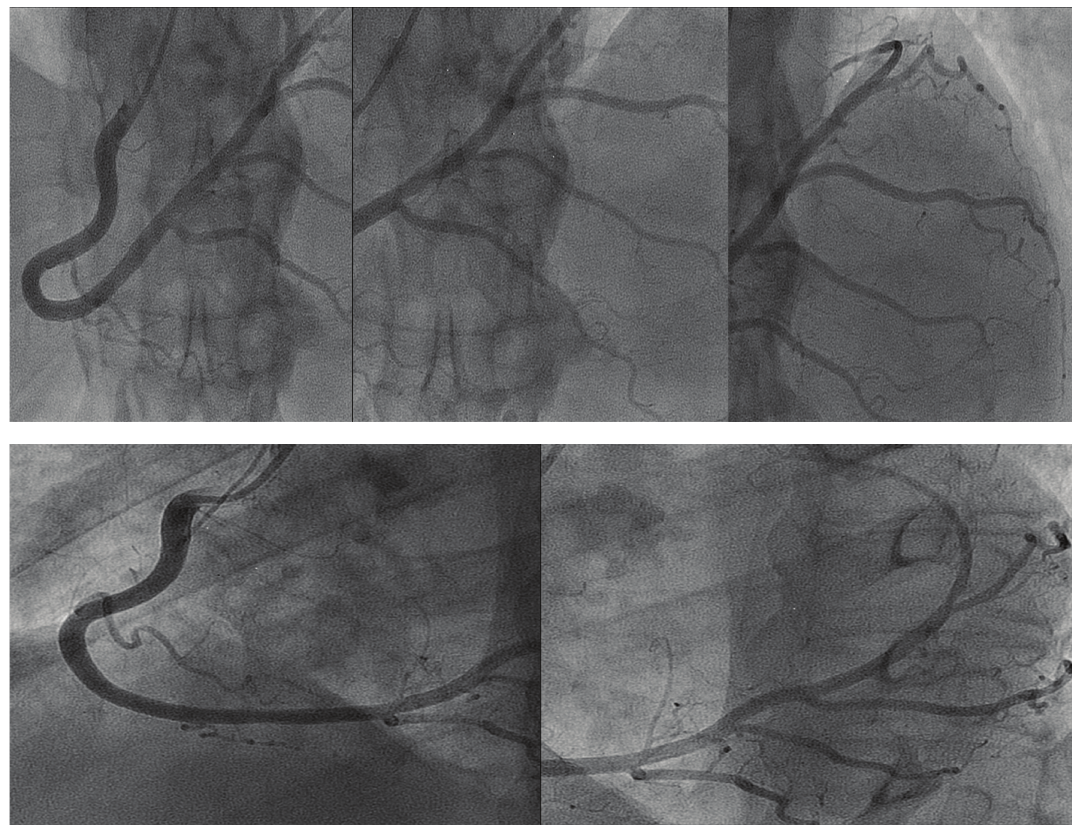
Figure 1: Reconstruction, by subsequent images, of the superdominant RCA, with various posterior descending branches, extending beyond the crux cordis and circling the atrioventricular groove, following the expected path of the absent circumflex artery. Superior panel: cranial left anterior oblique view. Inferior panel: left anterior oblique view. RCA: right coronary artery.